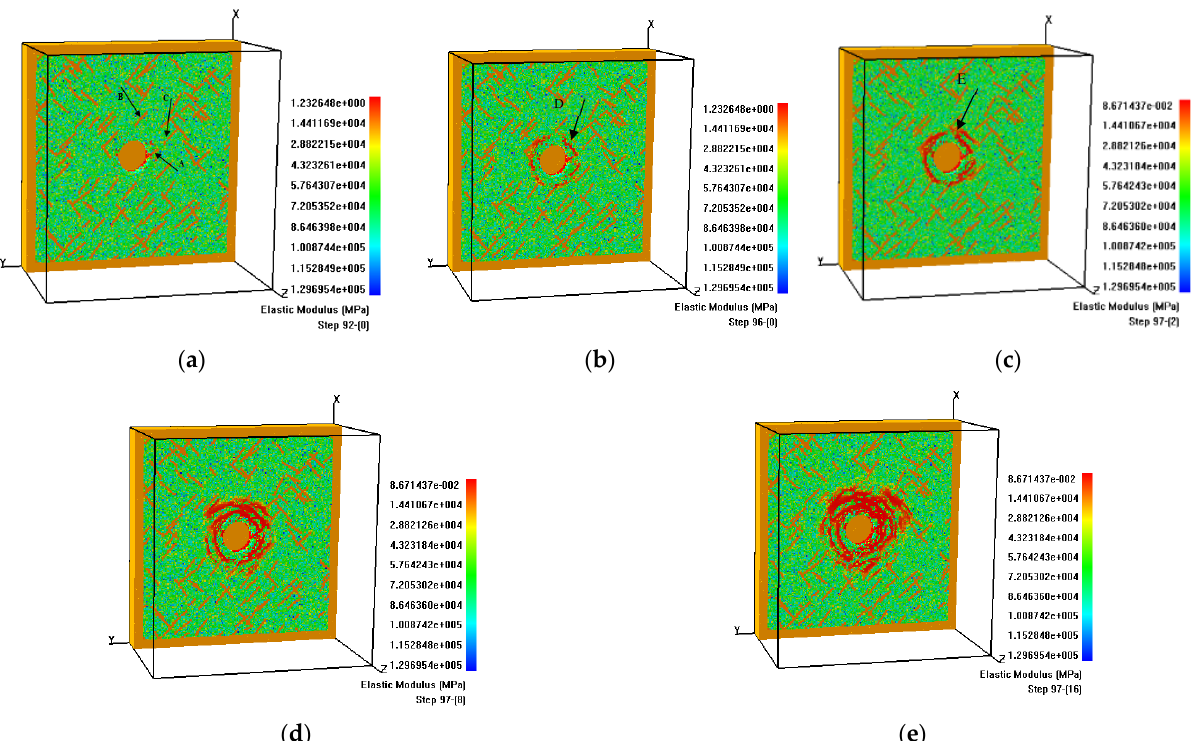
Figure 14. Elastic modulus distribution during zonal disintegration process of randomly jointed surrounding rock: ( a ) Step 92; ( b ) Step 96; ( c ) Step 97-2; ( d ) Step 97-8; ( e ) Step 97-16.